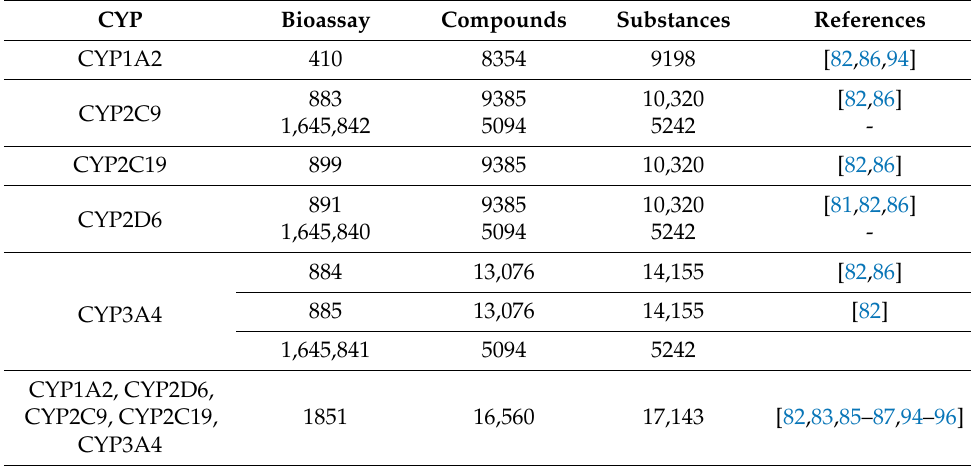
Table 1. Major datasets of CYP isoforms in the PubChem BioAssays database.